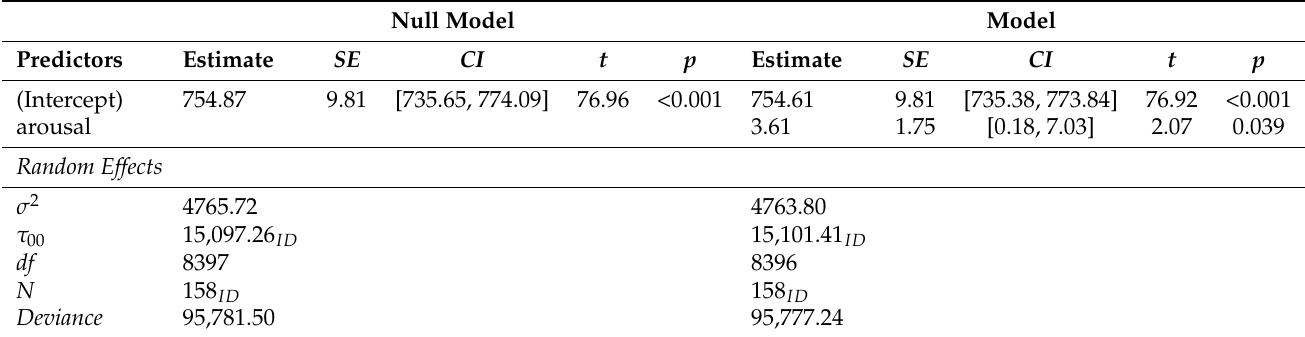
Table A10. Mixed model of the influence of emospace arousal widget response vector results on the mean RR